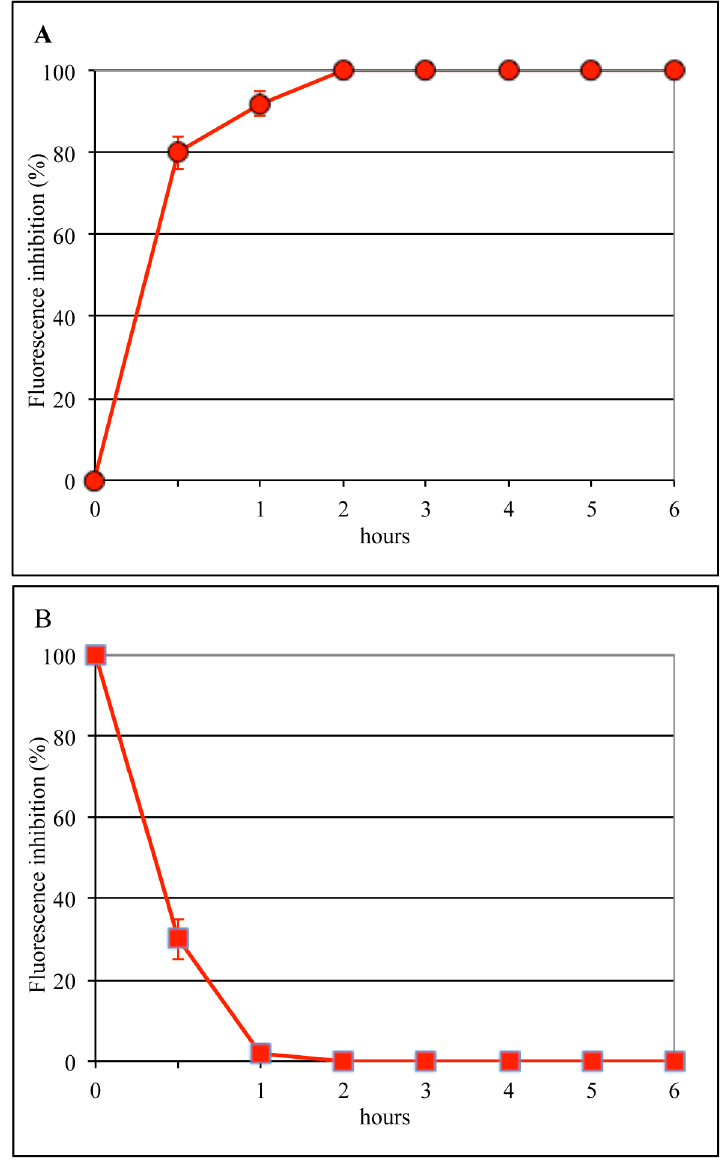
Figure 2. Dependence of 12.5 µM bLf time of addition on infection by the A/RomaISS/2/08 H1N1 strain. BLf was incubated with the cells directly after the virus-binding step and left for different periods of time ( A ), or, after virus adsorption, infected cells were kept at 37 °C for various periods of time before bLf addition ( B ). Six hours after viral infection, the synthesis of viral antigens was assessed by indirect immunofluorescence.